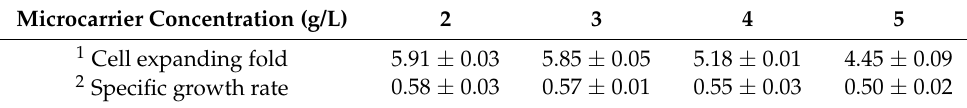
Table 2. Cell expansion fold and specific growth rate at different microcarrier